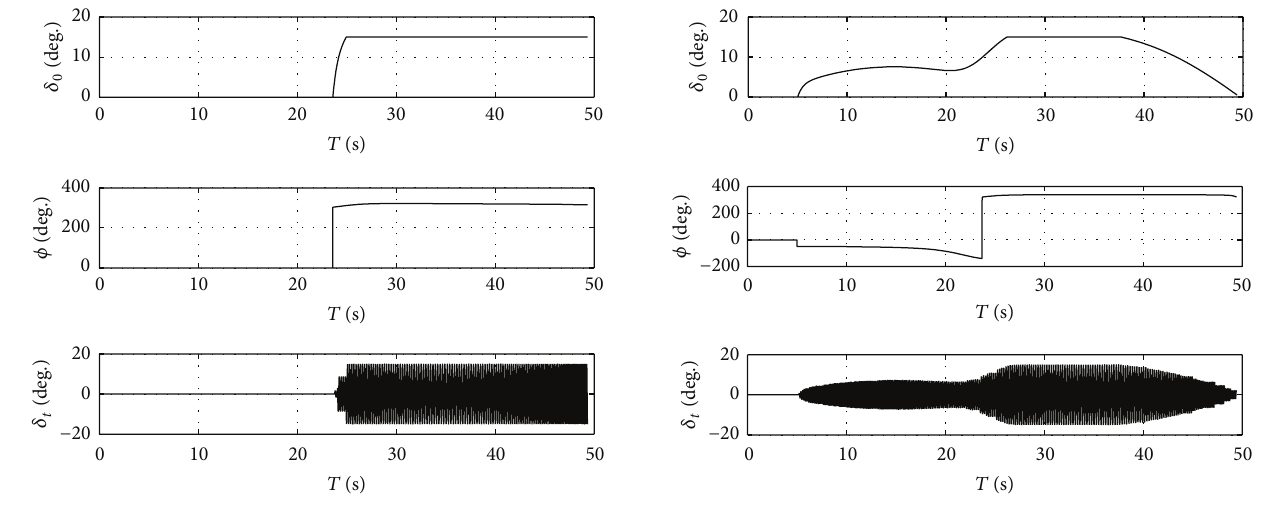
Figure 22: The deflection angle and control phase histories of the controlled trajectory with traditional trajectory correction scheme.